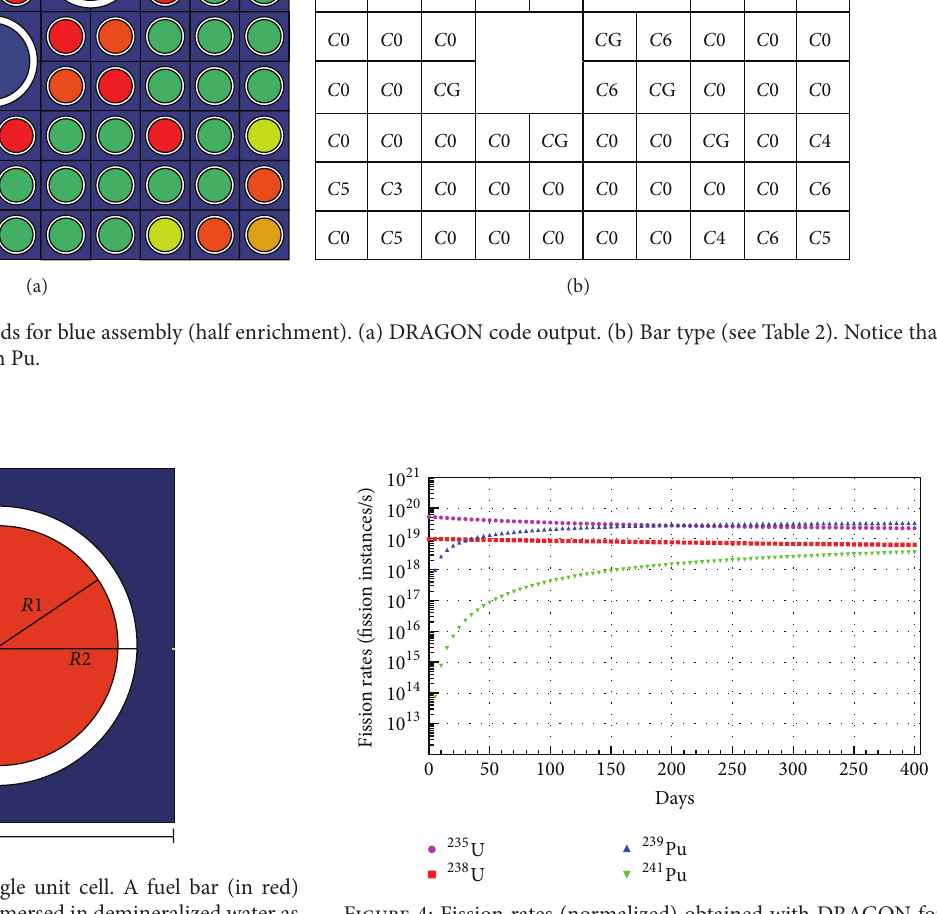
Figure 4: Fission rates (normalized) obtained with DRAGON for the 4 main fissile isotopes in the 444 fuel assemblies that make up the core of BWR-5 of 2.027 GWth like the LVNPP